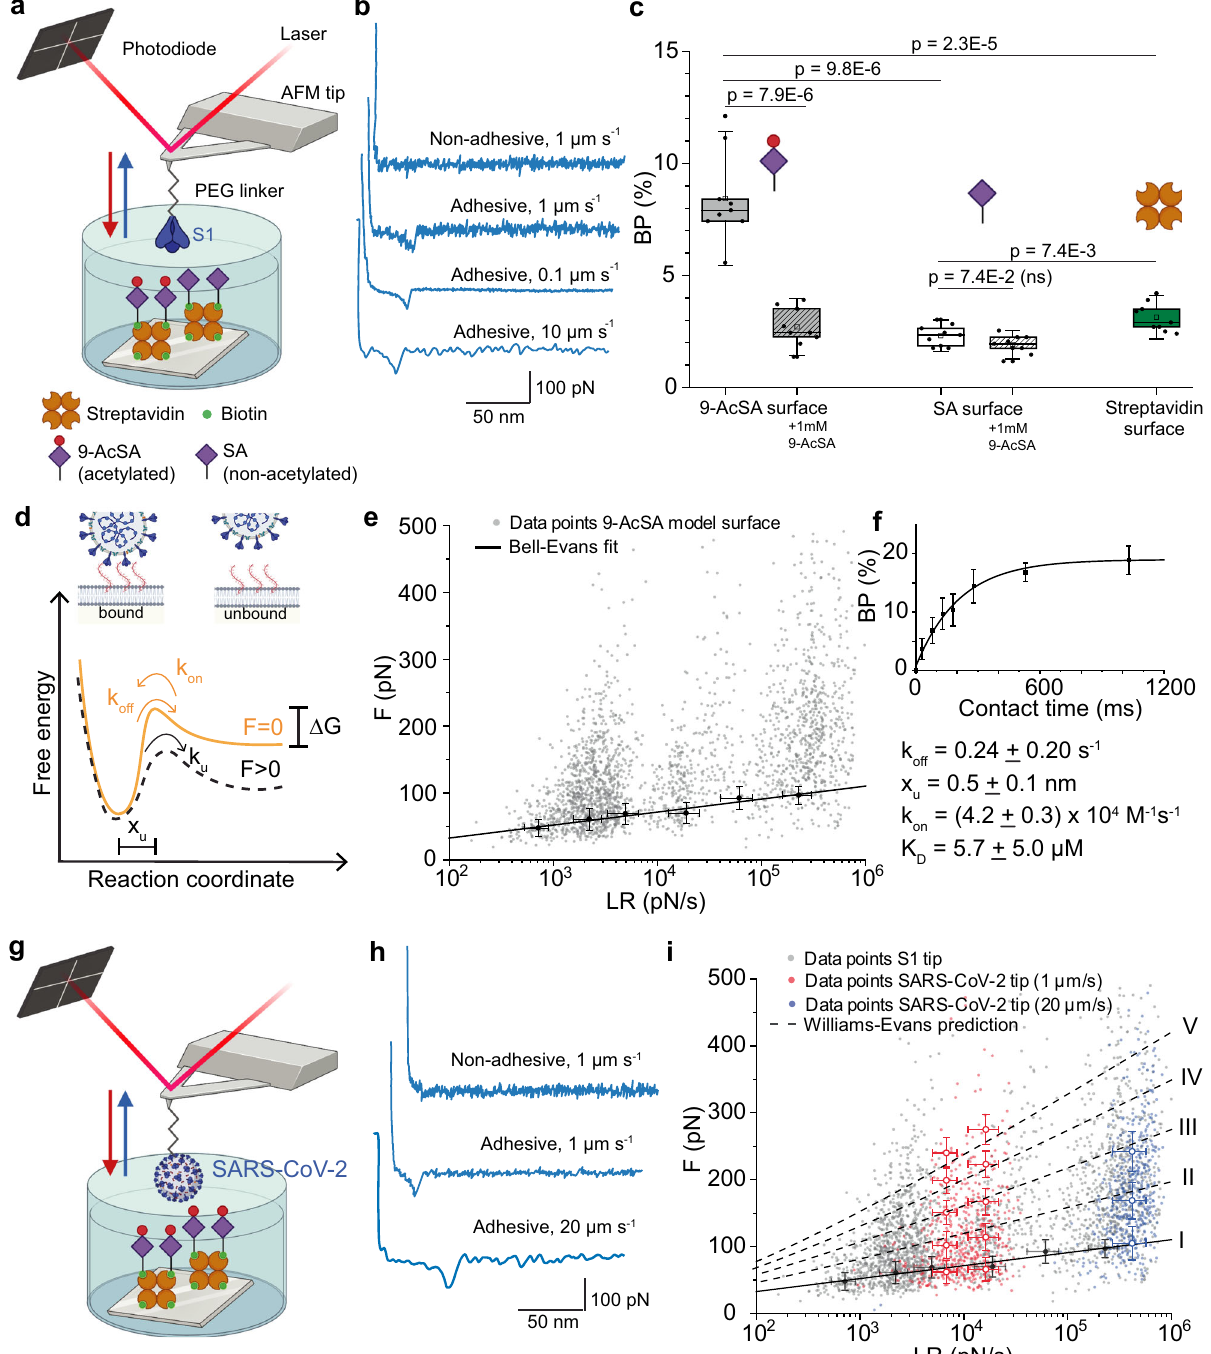
presenting sialic acids as potential competitors of this